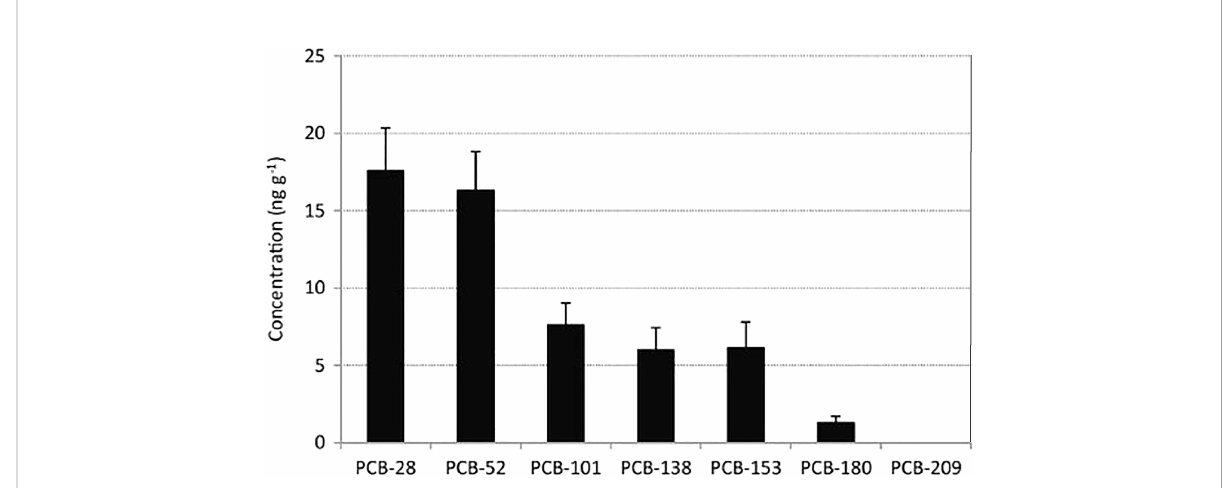
FIGURE 7 Figure represents the mean concentration of PCBs in plastic pellets (n=72) [Imprinted from (Jayasiri et al.,